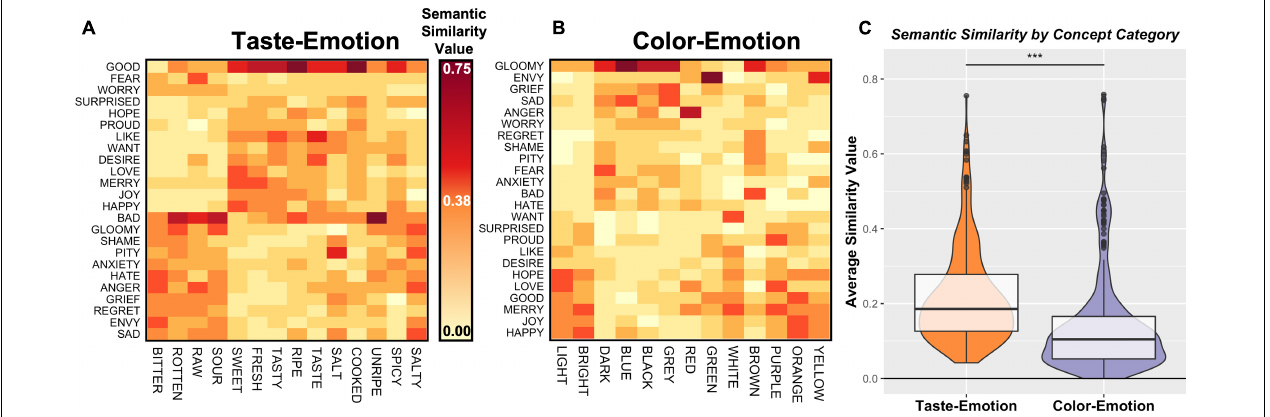
FIGURE 2 | The semantic similarity of Taste and Emotion concept pairs is greater than that of Color and Emotion Concept pairs. We compared the similarity of (A) Taste and Emotion concept pairs to (B) Color and Emotion concept pairs by selecting the relevant cells of the matrix and comparing the average similarity values within. (C) The results of this analysis show that participants judged taste concepts to have greater conceptual similarity to emotion concepts than did color concepts. *** p < 0.001.